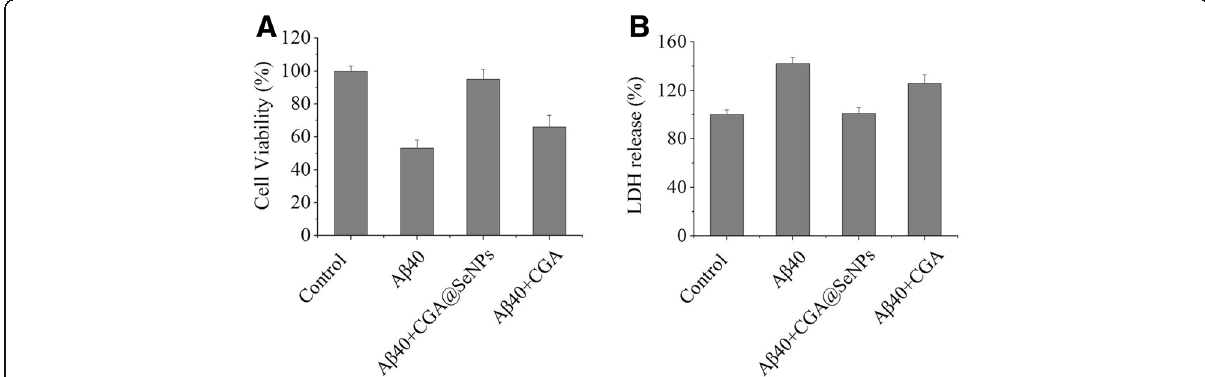
Fig. 5 The neurotoxicity of A β 40 incubated with or without CGA@SeNPs/CGA. a The cell viability of PC12 cells toward A β 40 in the presence of CGA@SeNPs or CGA tested by MTT assay. b The release of LDH into the culture medium. A β 40 = 35 μ M, CGA@SeNPs/CGA = 60 μ